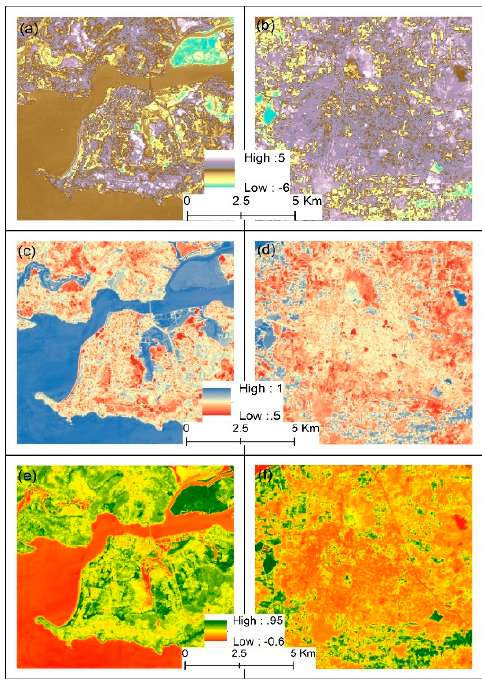
Figure 4. Images of the Enhanced Built-Up and Bareness Index (EBBI) for Panaji ( a ) and Tumkur ( b ); the Modified Normalized Di ff erence Water Index (MNDWI) for Panaji ( c ) and Tumkur ( d ) and the Soil Adjusted Vegetation Index (SAVI) for Panaji ( e ) and Tumkur ( f